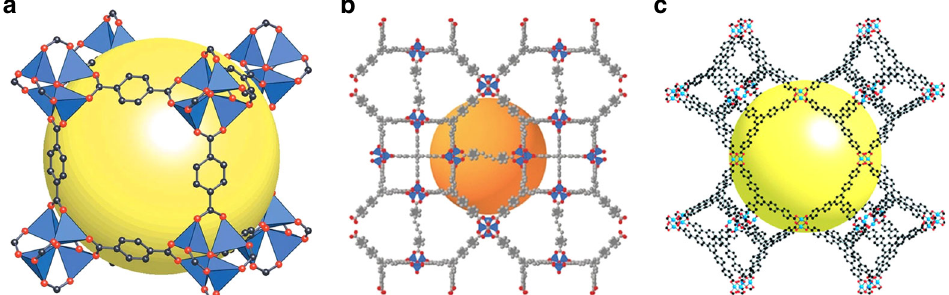
Fig. 2 Structures of selected MOFs. a Structure of MOF-5, showing how ZnO 4 tetrahedra (blue) are joined by 1,4-benzenedicarboxylate linkers (O in red and C in black) to give a cubic framework. The yellow surface represents the largest sphere (diameter 12 Å) that can occupy pores without contacting the van der Waals surface of the framework. Adapted with permission from Springer Nature, ref. 20 . b Structure of DUT-60, with ZnO 4 tetrahedra shown in blue and with atoms of the linkers in red (oxygen) and gray (carbon). The orange surface represents the largest sphere (diameter 36 Å) that can occupy the largest pores without contacting the van der Waals surface of the framework. Adapted with permission from John Wiley & Sons, Inc. (Wiley), ref. 40 . c Structure of MOF-399, with atoms shown as in a . The yellow surface represents the largest sphere (diameter 43 Å) that can occupy the largest pores without contacting the van der Waals surface of the framework. Adapted with permission from the American Chemical Society (ACS), ref. 43 . In all three fi gures, atoms of hydrogen have been omitted for clarity.